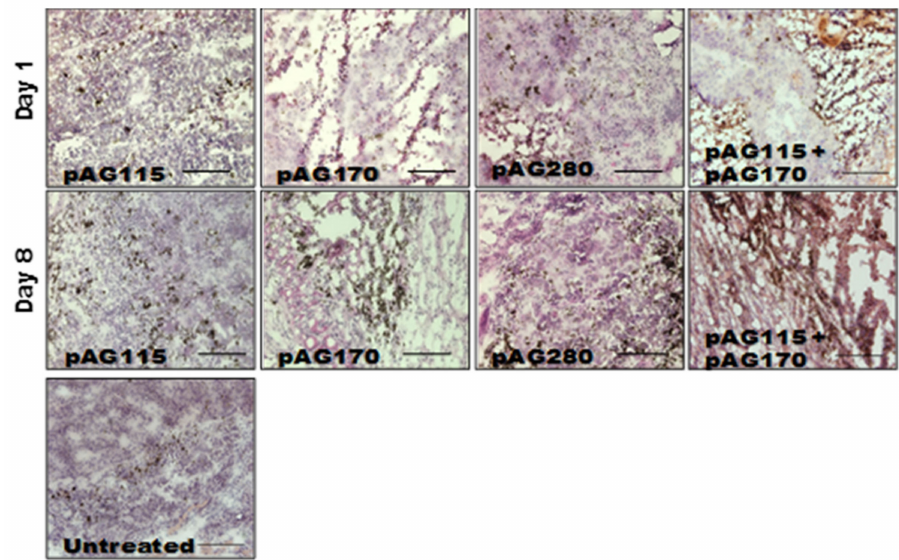
Figure 5. Histology of tumors after electrotransfer. Hematoxylin and eosin stained sections of tumor collected on day 1 (24 h after the first treatment) and on day 8 (24 h after the third treatment) after the electrotransfer of pAG115, pAG170, and pAC208 using EP2. Images are representative sections of n = 2 tumors. Scale bar = 500 µ m.